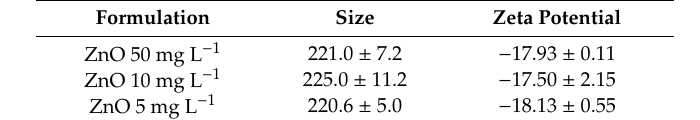
Table 1. Hydrodynamic size ( ± SD) (diameter in nm) and zeta potential ( ± SD) (mV) values of the ZnO Figure 2. Distribution pattern of ZnO NPs from TEM micrographs. NPs (n = 3). Table 1. Hydrodynamic size (±SD) (diameter in nm) and zeta potential (±SD) (mV) values of the ZnO Table 1. Hydrodynamic size (±SD) (diameter in nm) and zeta potential (±SD) (mV) values of the ZnO NPs (n = 3). NPs (n = 3).